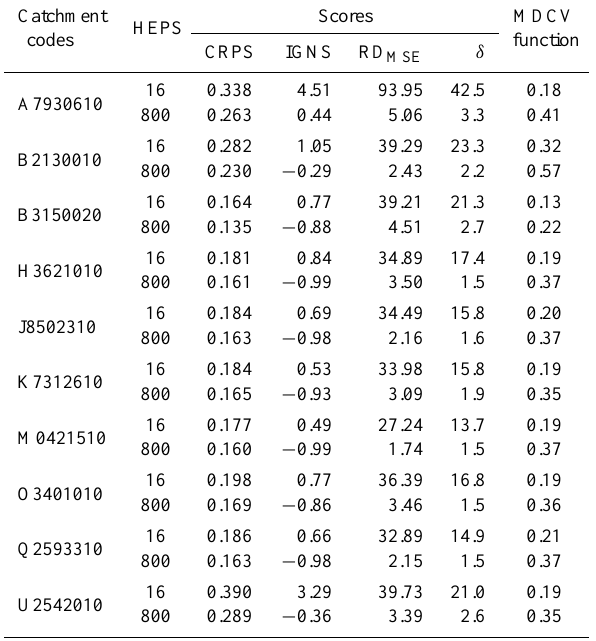
Table 3. Performance for the 16-member ensemble (16 hydrolog- ical models are driven by the deterministic forecast from ECMWF EPS) and the 800-member ensemble (16 hydrological models are driven by the 50 perturbed members forecast from ECMWF EPS) for a 9-day forecast time horizon. Hereafter, RD MSE values are expressed on a 10 − 3